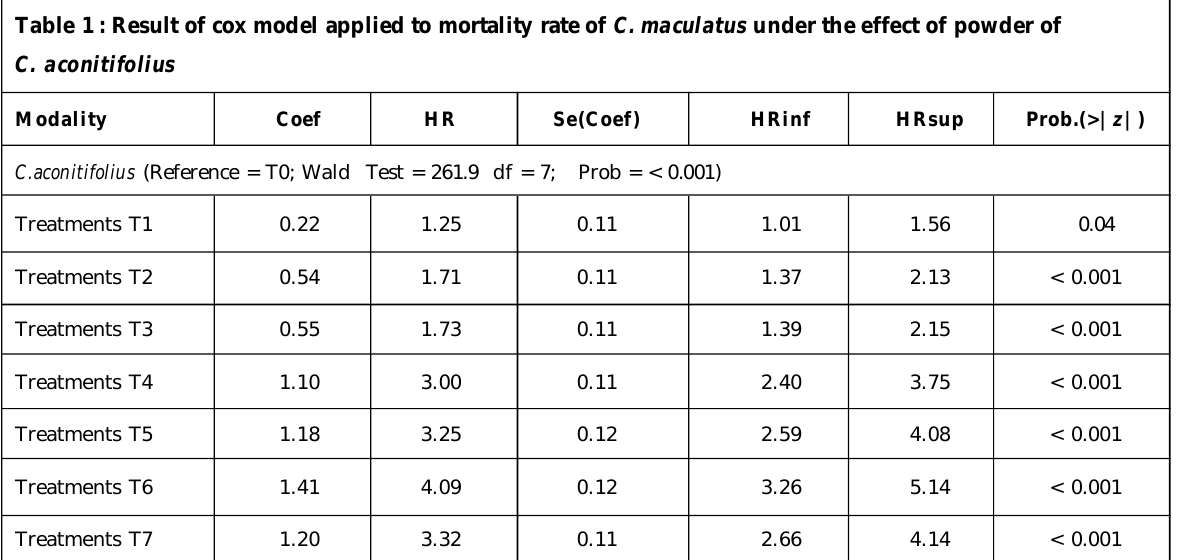
Figure 1 indicates insect mortality rate is positively correlated with dose of C. aconitifolius powder and exposure time. The median survival time of C. maculatus under treatments T5, T6 and T7 was four days, while it is five days for insects under treatments T4, T3 and T2. Half of the insects in control lot (TO) were still alive on day six and half of those under T1 treatment were still alive on day five.